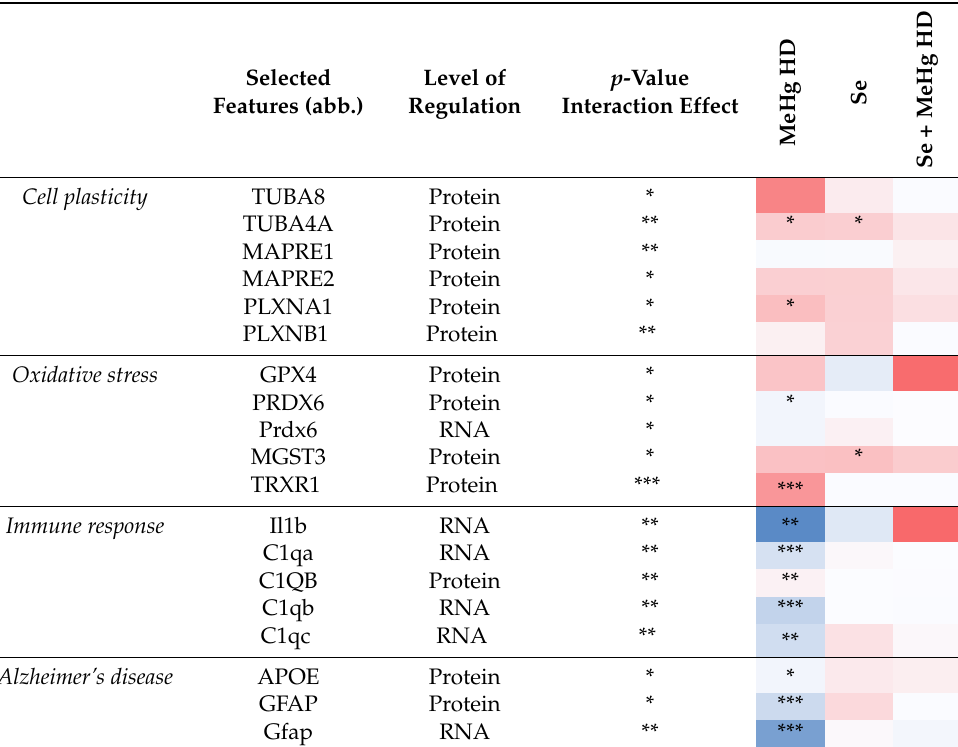
Table 4. Overview of selected features related to the overall categories of cell plasticity, oxidative stress, immune response and Alzheimer’s disease.